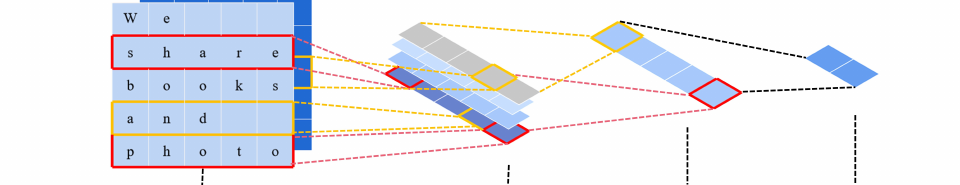
Figure 5. Two-channel Text-CNN network intent. After the convolution layer, it also traverses the linear layer. The input to the network is a representation matrix X ∈ R N × K . Where N is the number of characters in a word and K is the number of characters in a word that contains the most